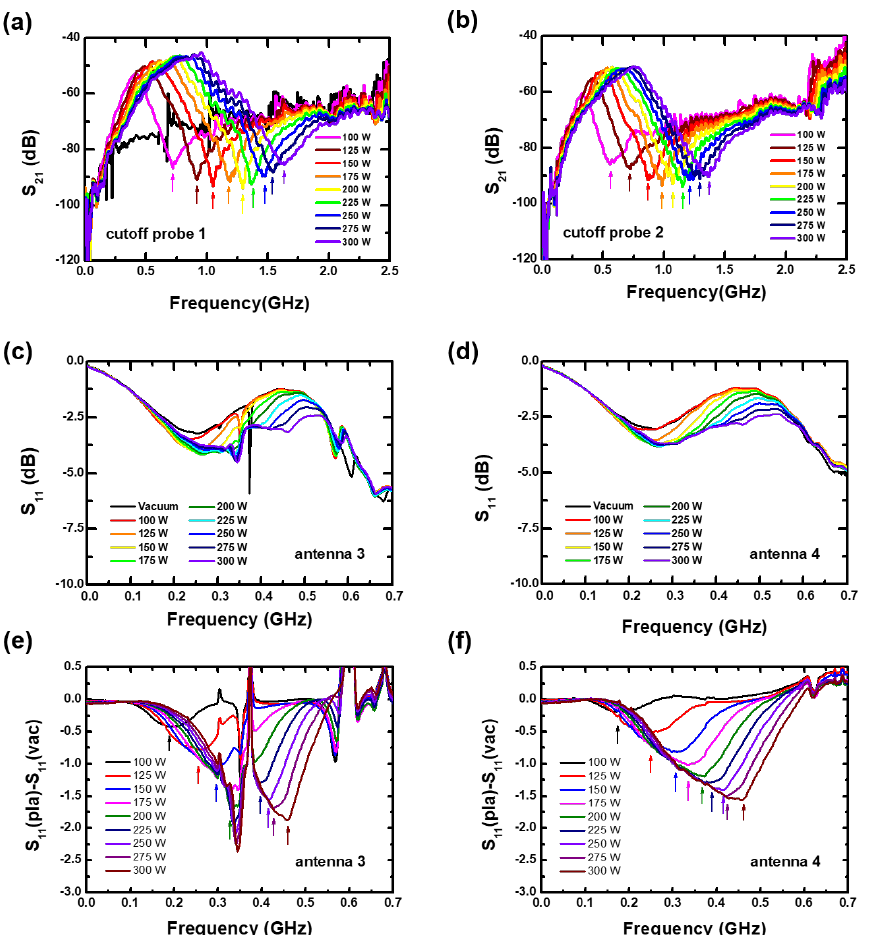
Figure 4. S 21 spectra of ( a ) the cutoff probe 1 and ( b ) cutoff probe 2. S 11 spectra of ( c ) the antenna 4 and ( d ) the antenna 3. S 11 (pla) − S 11 (vac) spectra of ( e ) the antenna 4 and ( f ) the antenna 3. All data are gathered at a pressure of 100 mTorr and various RF power from 100 to 300